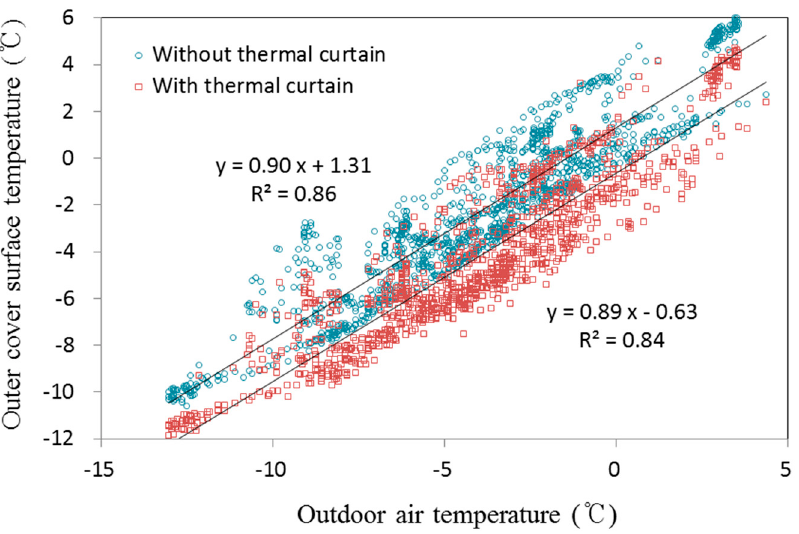
Figure 6. Outer cover surface temperature as a function of outdoor air temperature without and with thermal curtains.